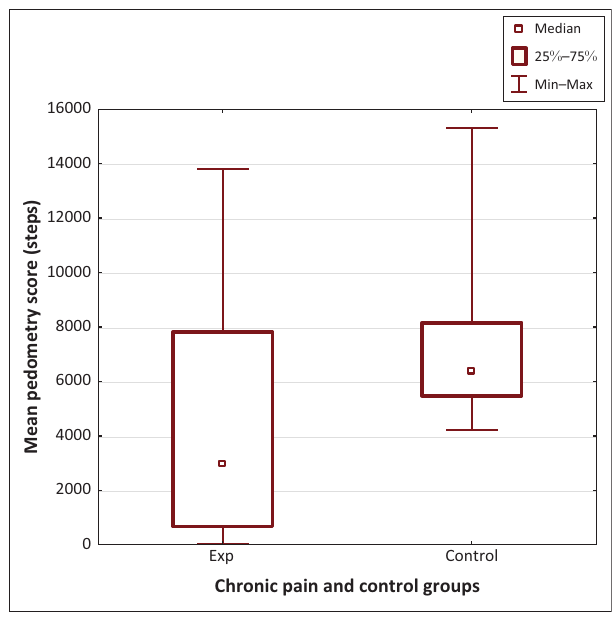
FIGURE 3: Mean pedometry scores for 7 days for the chronic pain and control